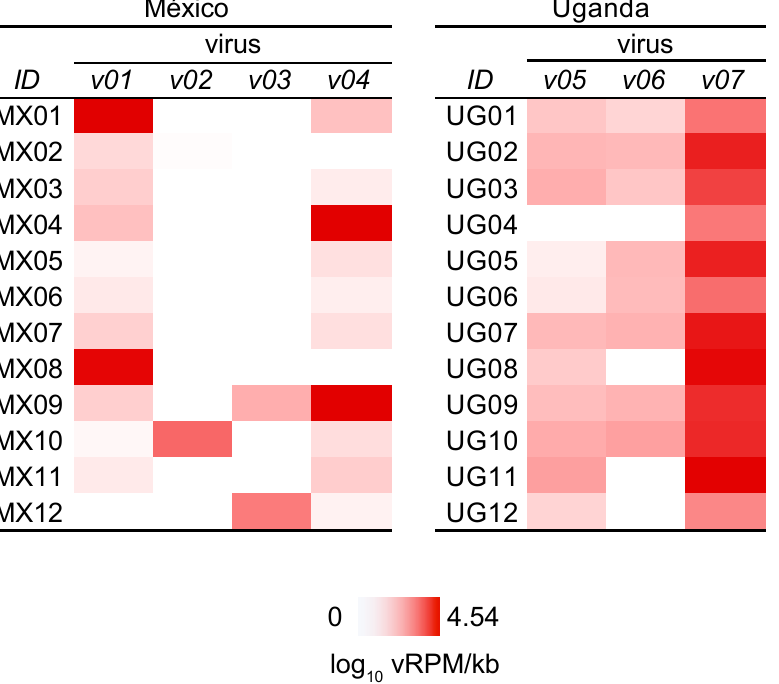
Figure 6. Heatmap of viral loads in streblid bat flies from México and Uganda. Data are log 10 viral reads per 10 6 total reads per kilobase of target sequence for each virus in each bat fly (MX01-MX12 and UG01-UG12): méjal virus (v01), Amate virus (v02), jalimé iflavirus 1 (v03), jalimé partiti-like virus 1 (v04), mamucuso virus (v05), kamu rhabdovirus 1 (v06), and kamu toti-like virus 1